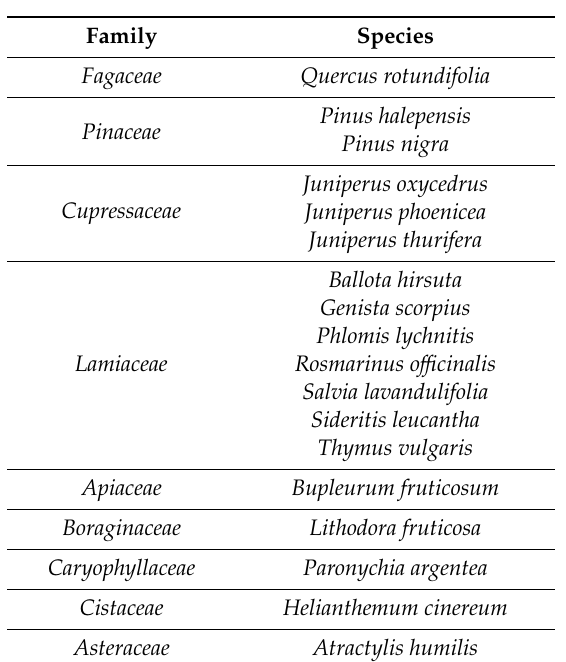
Table 1. List of plants grazed by sheep in the Mediterranean